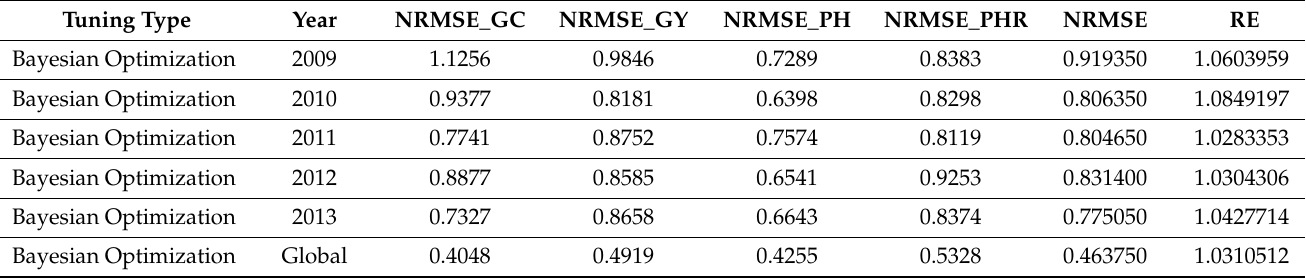
Table A1. The prediction performance for every environment and across environments (Global) of the dataset 1 (Japonica) in terms of normalized root mean square error (NRMSE) under three methods of tuning (BO, GrS and NT) for the Japonica dataset. RE denotes relative efficiency. The RE in the rows corresponding to BO were computed dividing the NRMSE under NT by the NRMSE under BO. The RE in rows corresponding to GrS were computed dividing the NRMSE under NT by the NRMSE under GrS. RE in the rows corresponding to the NT strategy were computed dividing the NRMSE under GrS by the NRMSE under